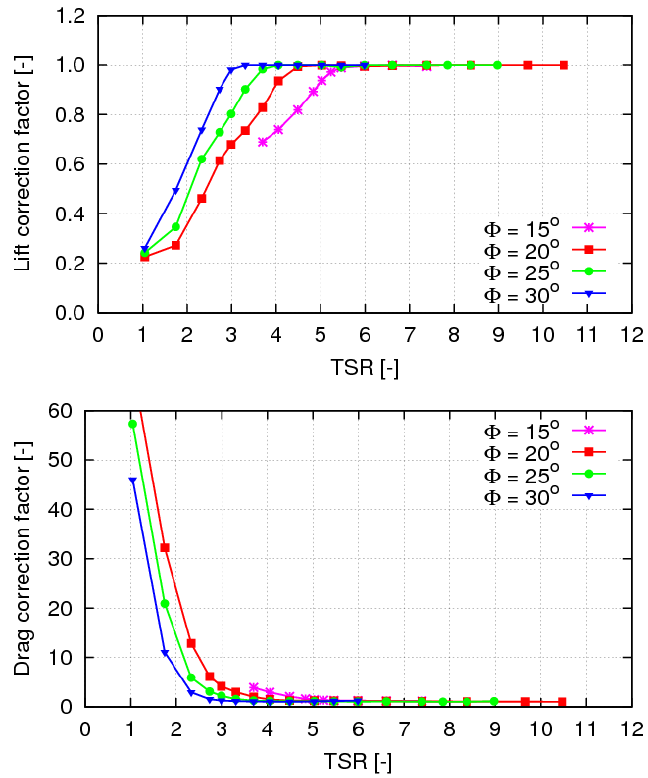
Figure 24. UoS-VP turbine. Lift correction factor K radius r / R = 0.7 for different Pitch